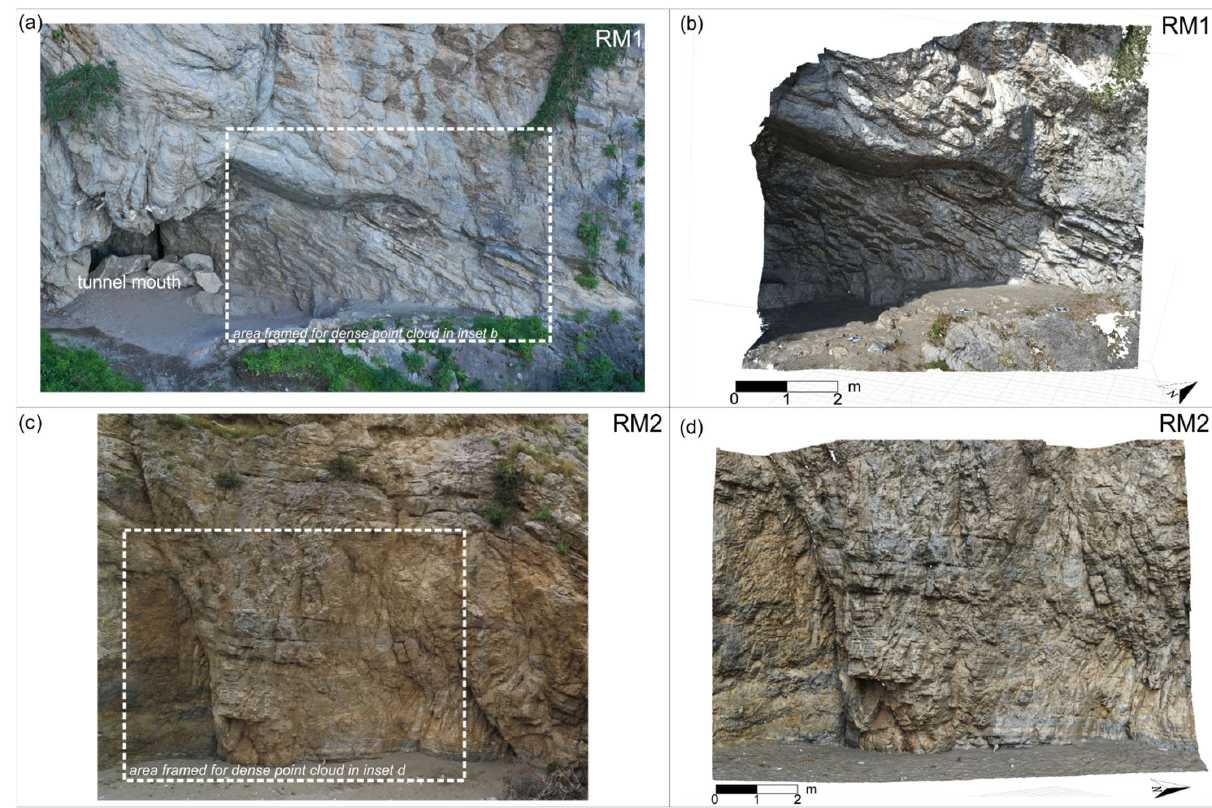
Figure 2. ( a ) Photo of RM1 rock wall with indication of the area framed for the dense point cloud construction; ( b ) dense point cloud built by SfM for RM1; ( c ) photo of RM2 rock wall with indication of the area framed for the dense point cloud construction; ( d ) dense point cloud built by SfM for RM2.